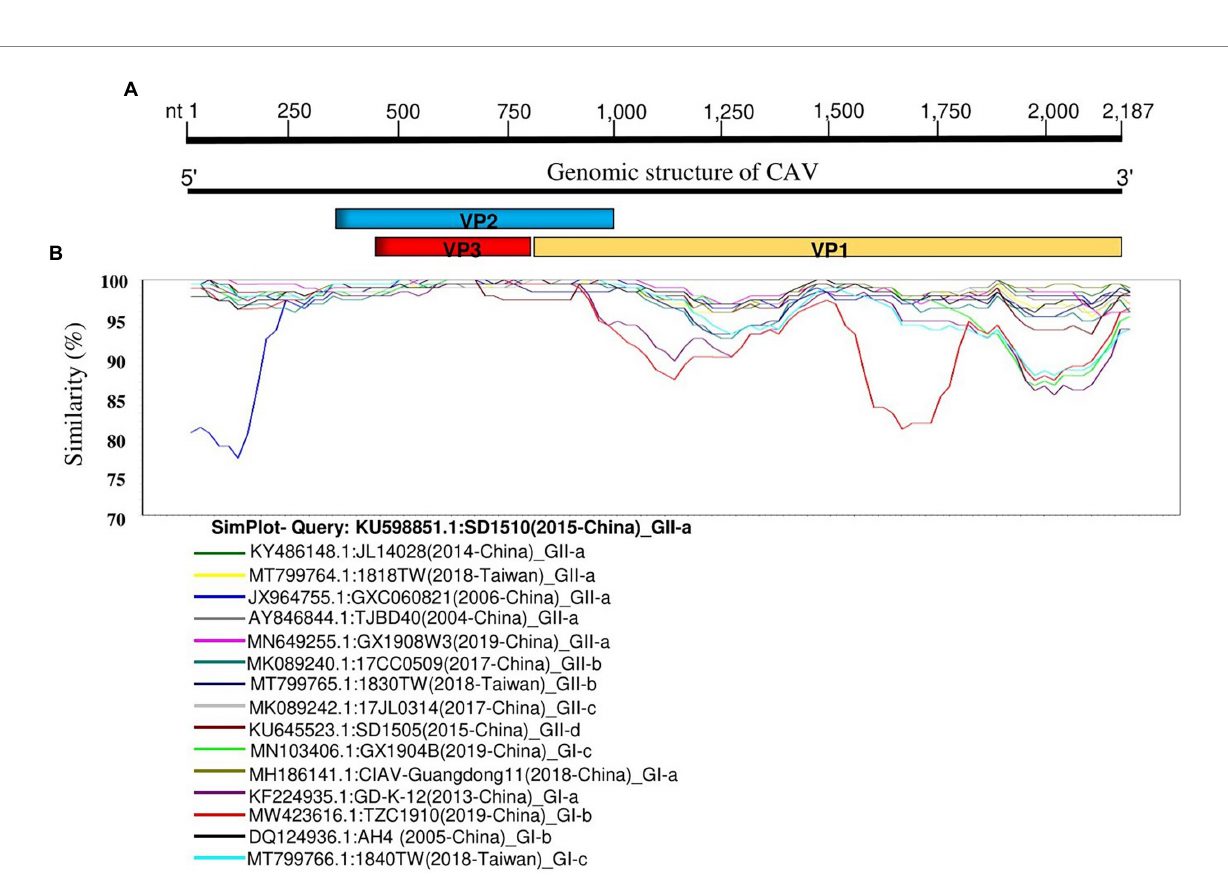
FIGURE 2 Genetic similarity map of the full-length genome sequences of representative CAV strains. (A) Schematic diagram of CAV complete genome structure. From 5 ′ end to 3 ′ end are the three overlapping ORFs that encode for the VP2, VP3, and VP1 proteins. (B) SimPlot similarity analysis results using the SD1510 (2015-China) strains within the GII-a (GenBank ID: KU598851.1) as the query sequence to compare with the fifteen other representative strains from each